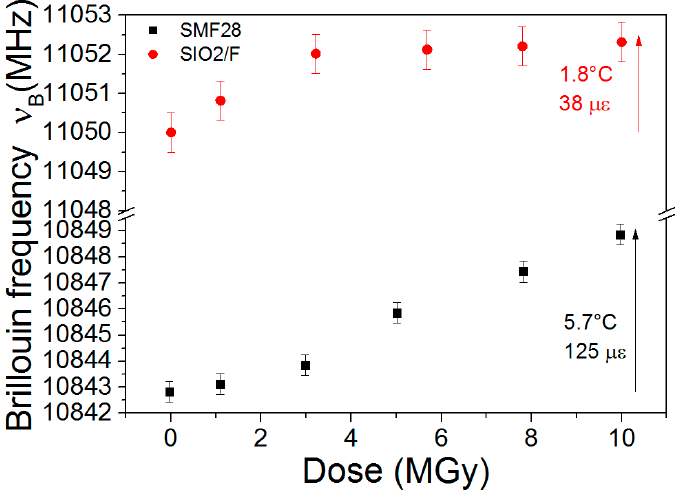
Figure 23. Measured Brillouin frequency shift for standard fibre with Ge dopants and F-doped fibre